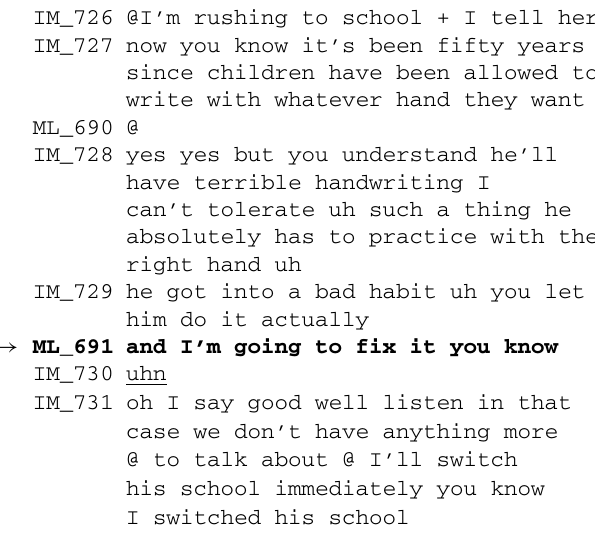
unit (coded 3 on tier2) and are associated with a rising list contour, RL (tier3). The final item produced by the listener (tier4) ends in an intonative unit (coded 3 on tier5) and is associated with a final falling contour, F